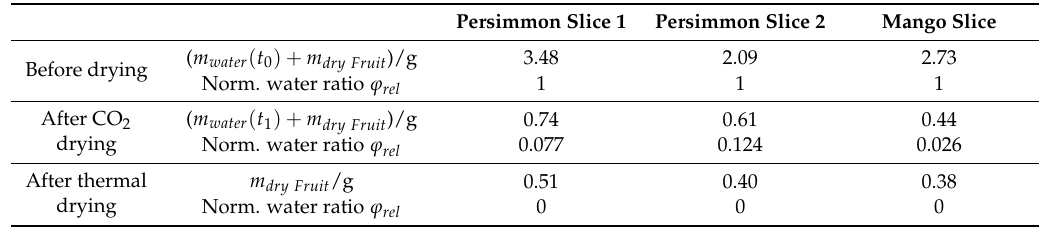
Table 1. Masses and normalized water mass ratios of the fruit slices before the CO 2 drying experiment, after CO 2 drying and after complete drying in a thermal dryer (normalized to the water mass ratio before